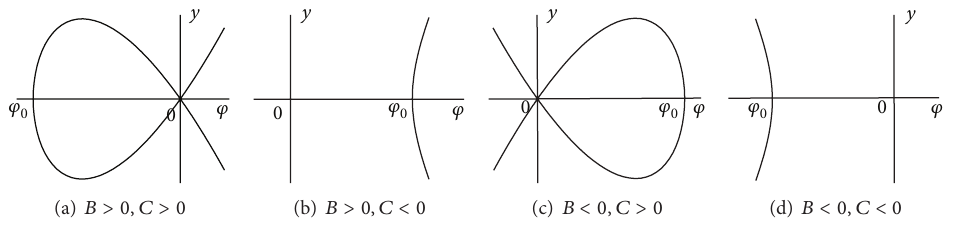
Figure 1: The bifurcation phase portraits of system (6) with 𝐴 = 0 .